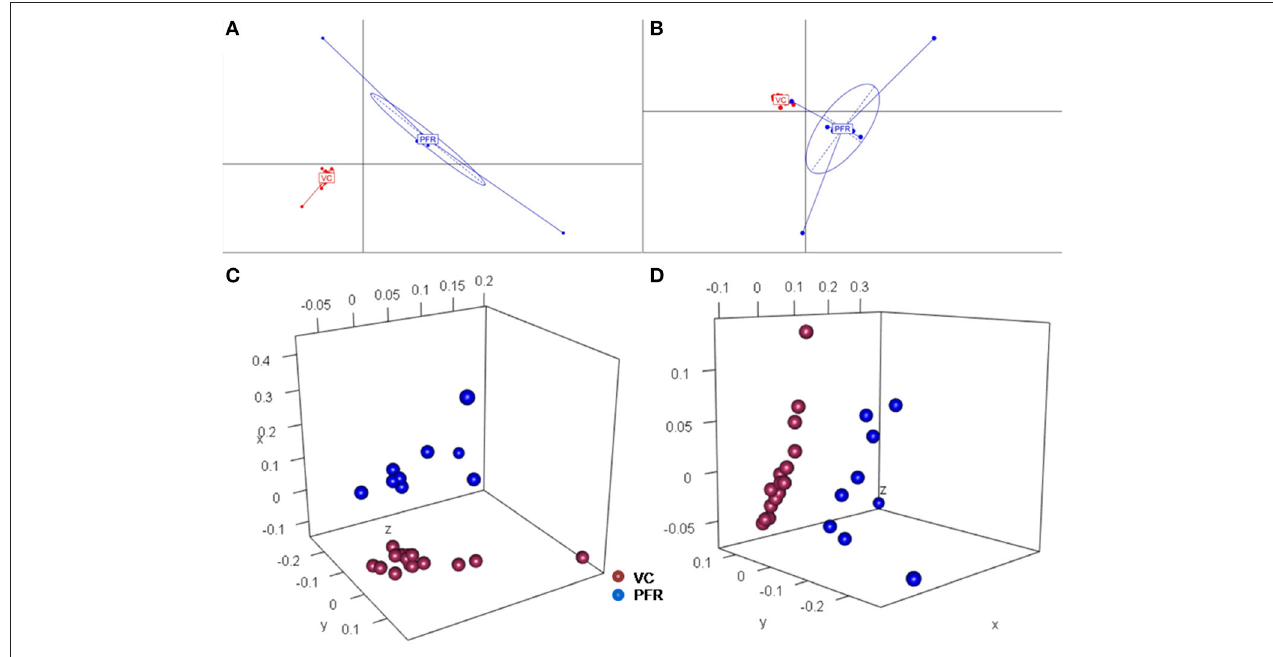
FIGURE 3 | Principal coordinate (PCoA) and Non-metric multidimensional scaling (NMDS) analysis in controls (VC) and post-fever retinitis (PFR) groups. PCoA plots are based on Jacard distances of eukaryotic viral genera (A) and Bacteriophages (B) . Three-dimensional NMDS are based on Bray-Curtis distances of Eukaryotic viruses (C) and Bacteriophages (D)